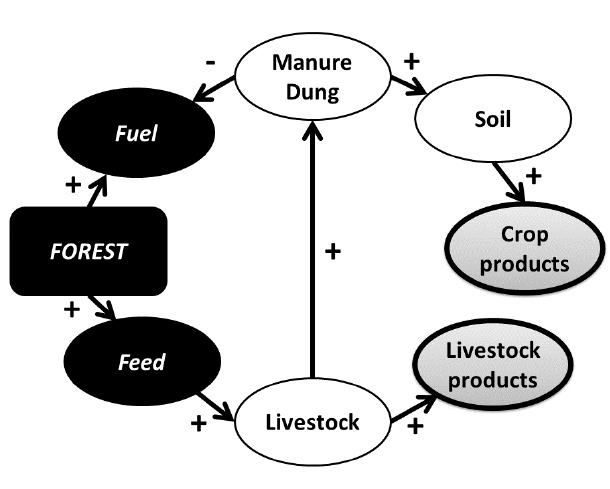
Fig. 6 . Schematic representation of the effect of forest (and other commons) on the quantity and quality of crop and livestock products. The “+” signs show positive relationships; the “-” signs show negative